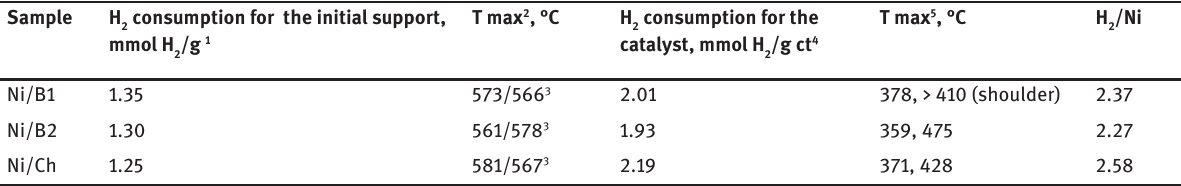
Figure 8: TPR profiles of the initial supports (A) calcined at 600°C (solid line) or 800°C (dashed line), and Ni/Ce Zr O catalysts (B): 1 – B2 (Ni/B2), 2 – B1 (Ni/B1), 3 - Ch (Ni/Ch). x 1-x 2